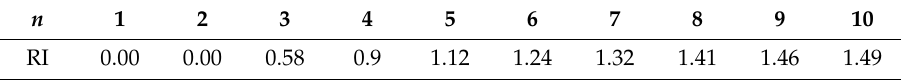
Table 8. Random consistency index (RI) at different number of indicators ( n )